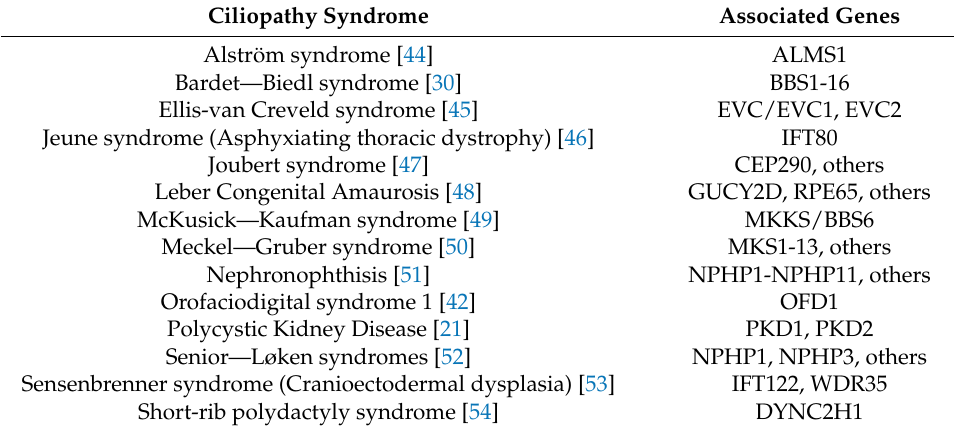
Table 1. Known human ciliopathies. A list of known human ciliopathies, though many more are thought to be related to cilia function. Ciliopathies present with significant variation in phenotype depending on the underlying gene mutation and other factors. Due to historical clinical defini- tions, some syndromes are phenotypes possible from a variety of gene mutations, while others are phenotypic variations of the same genetic defect